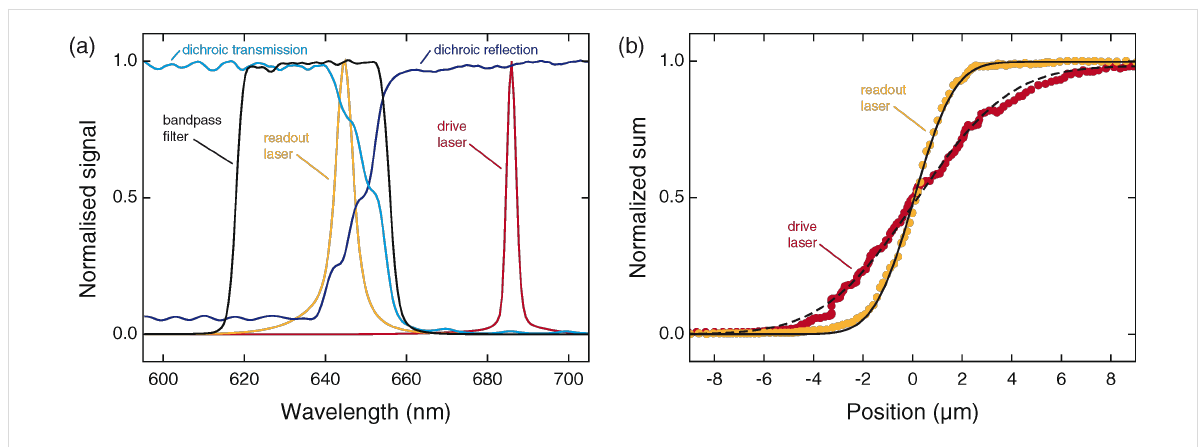
Figure 2: a) Measured spectra of the major optical components in the readout design. b) Measurement of the beam waist of the readout and drive laser. The 1/ e 2 waist of the readout and drive laser are 2.6 μ m and 5.9 μ m, respectively.